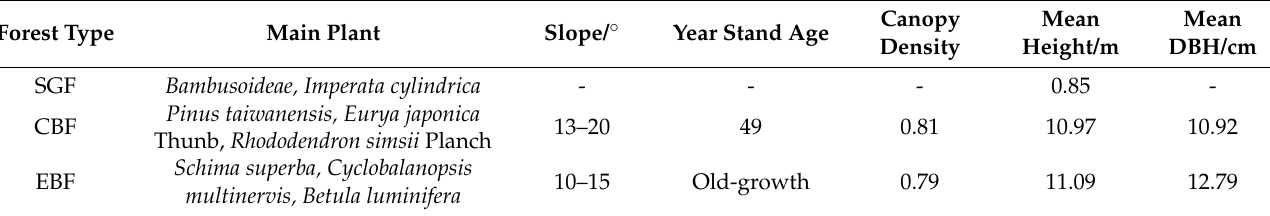
Table 1. General situation of the trees in sample